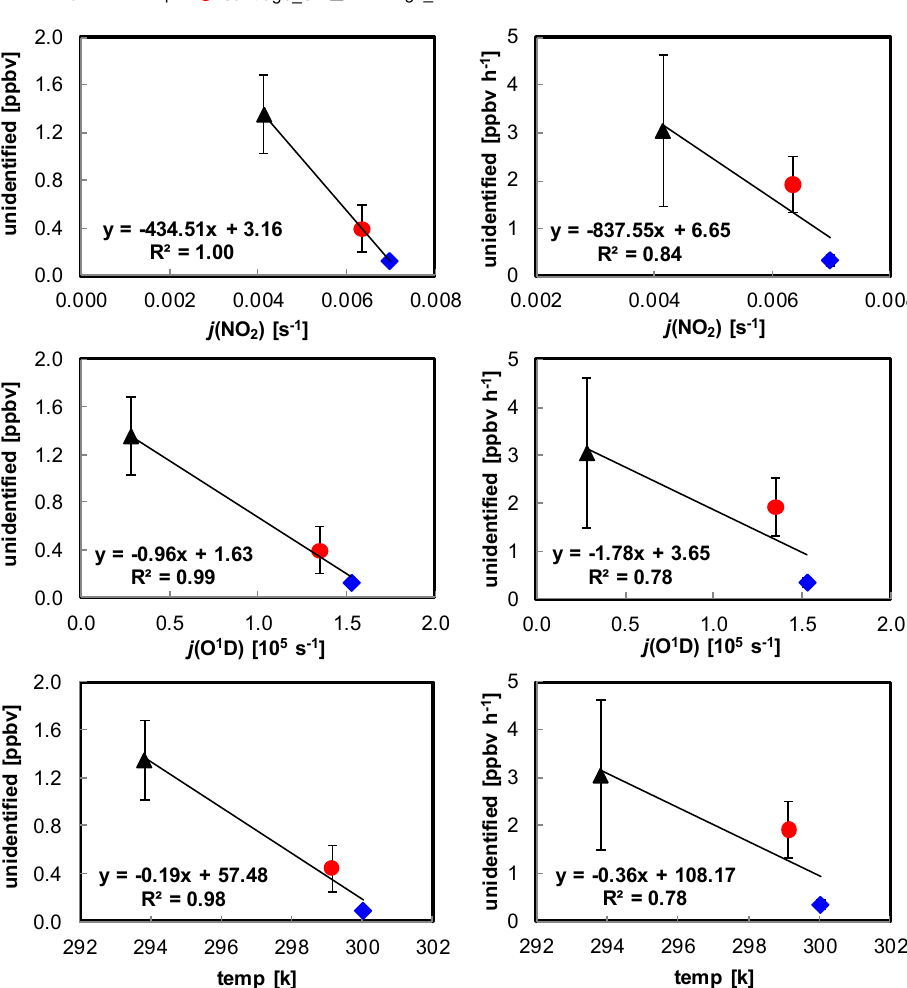
Fig. 9. Correlation between unidentified HONO mixing ratios and their source strength versus j (NO 2 ), j (O 1 D) and temperature observed in Figure 9: Correlation between unidentified HONO mixing ratios and their source strength field measurement campaigns with a HONO/NO x ratio of > 0.02. Error bars represent 1 σ of the versus j (NO 2 ), j (O 1 D) and temperature observed in field measurement campaigns with a HONO/NO x ratio of >0.02. Error bars represent 1 σ of the mean.